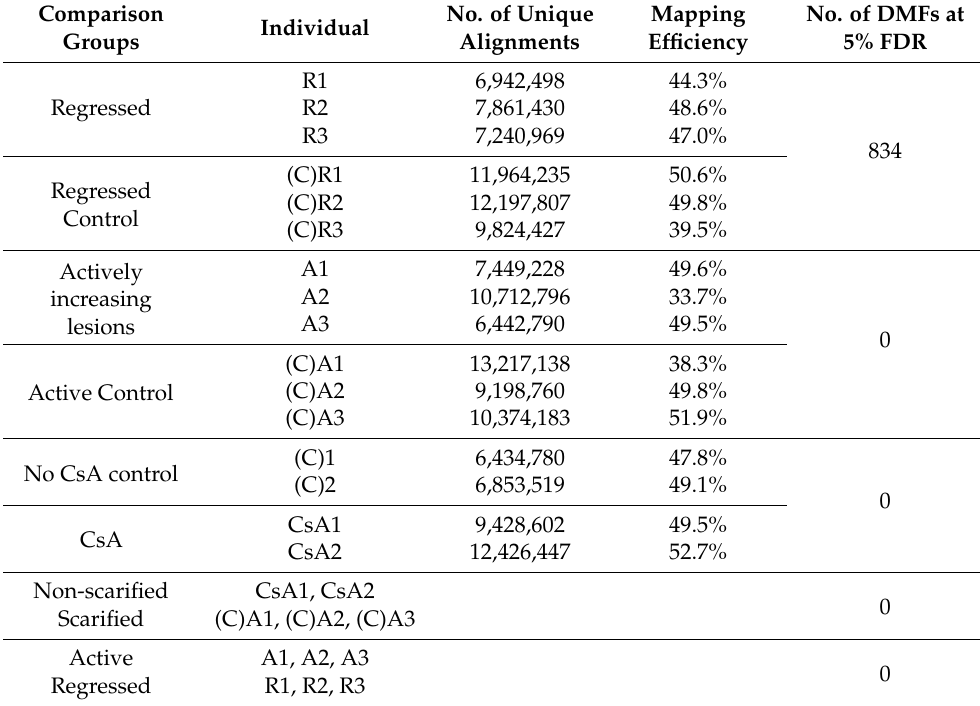
Table 1. Methylation alignment and efficiency by individual sample and number of differentially methylated fragments (DMFs) using Benjamini–Hochberg correction for each group